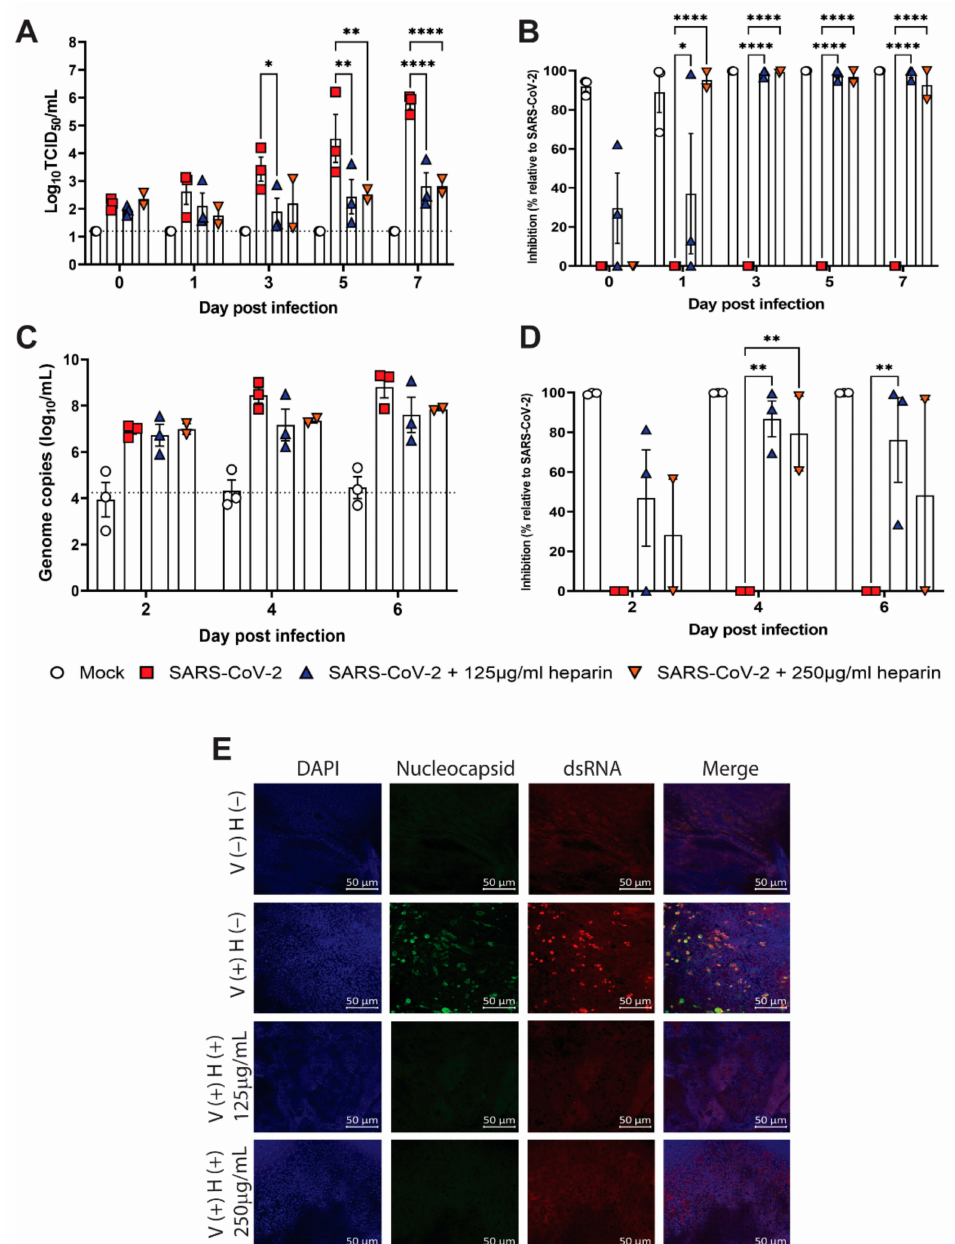
Figure 3. Heparin inhibits SARS-CoV-2 infection in human nasal epithelial cells. Infectious virus titers ( A ) and genome copies ( C ) on indicated days post infection in apical supernatants from cells cultured with or without heparin. Percent inhibition of virus titers ( B ) and genome copies ( D ) compared to SARS-CoV-2 infected cells cultured in the absence of heparin on the indicated days. Graphs show the mean +/ − SEM of 2–4 replicates from 3 individual donors analyzed in 3 separate experiments, except for 250 µ g/mL which was only tested in 2 donors. ( E ) Immunofluorescence images of cells at day 7 post infection stained for dsRNA (red), SARS-CoV-2 nucleocapsid (green) or DAPI (blue). Scale bar = 50 µ M. Data were analyzed using a Two-Way ANOVA with Dunnett’s multiple comparisons test. *, p < 0.05; **, p > 0.01 and ****, p < 0.0001. To confirm that intracellular virus was also decreased by heparin treatment, we stained human nasal epithelial cells for dsRNA and SARS-CoV-2 nucleocapsid at 7 dpi. While infected cells were observed in the untreated nasal epithelial cells, we did not find dsRNA or SARS-CoV-2 nucleocapsid stained cells in heparin-treated nasal epithelial cells (Figure